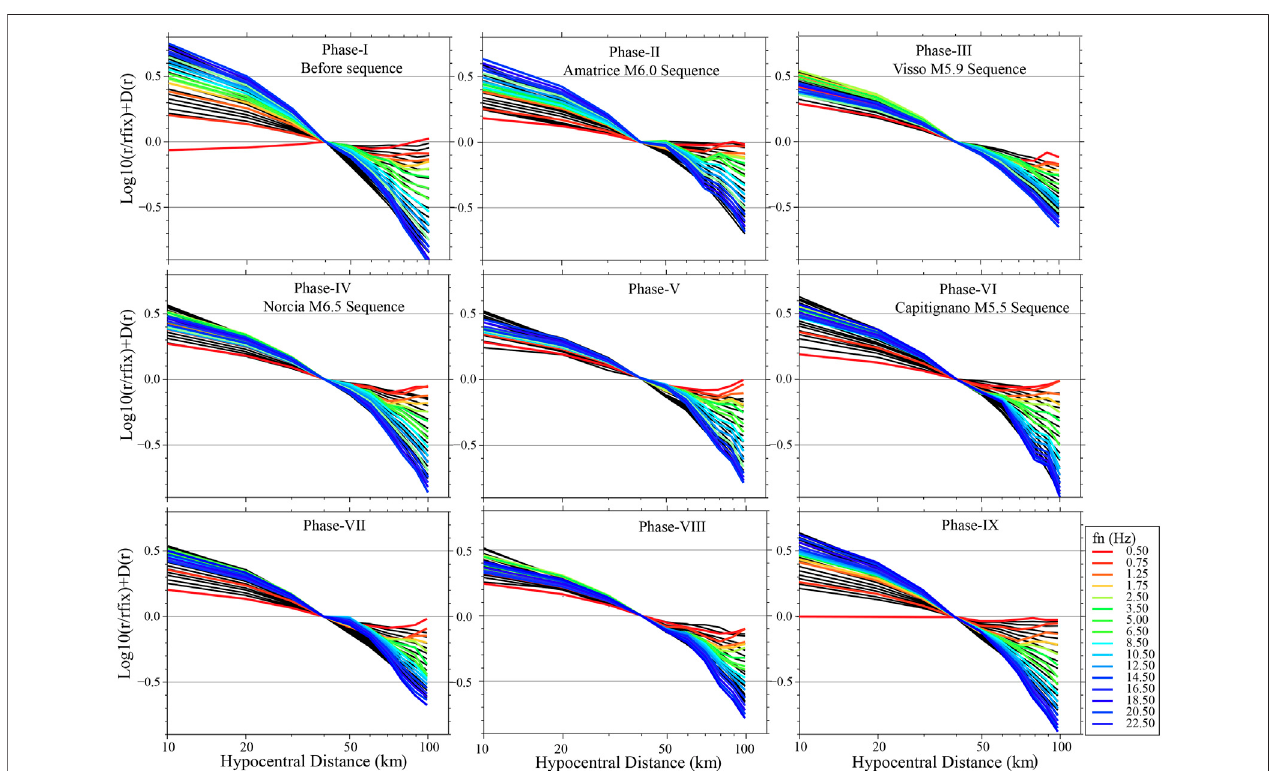
FIGURE 2 | Empirical regional attenuation, Path emp ( r , r fi x , f k ) curves experienced by the narrow-band fi ltered amplitudes of the ground motion, at the 16 central frequencies of 0.5, 0.75, 1.25, 1.75, 2.50, 3.50, 5.0, 6.5, 8.5, 10.50, 12.50, 14.50, 16.50, 18.50, 20.50, and 22.5 Hz that are shown by colored lines at each selected timeperiods.Blacklines inthebackgroundareobtainedwiththeattenuation model, Path theo ( r , r fi x , f k ).All linesarenormalized bya1/rdecay(thehorizontaldashed lines represent the 1/r decay). The reference hypocentral distance is 40 km.